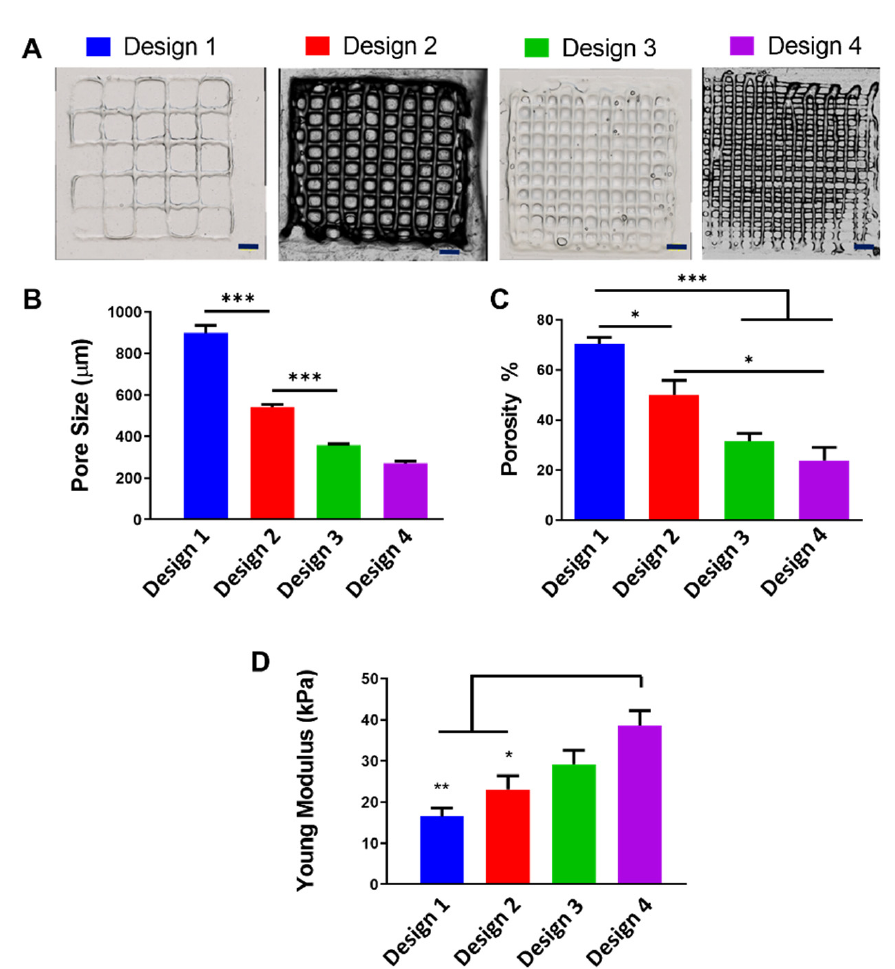
Figure 5. Altering intra-filament distance produced four scaffold designs ( A ). The effect of intra- filament distance on the pore size ( B ), porosity ( C ) and compressive modulus ( D ) of the scaffolds. * p < 0.05; ** p < 0.001; *** p < 0.0001 compared to design 1. Scale bar = 1000 µm.